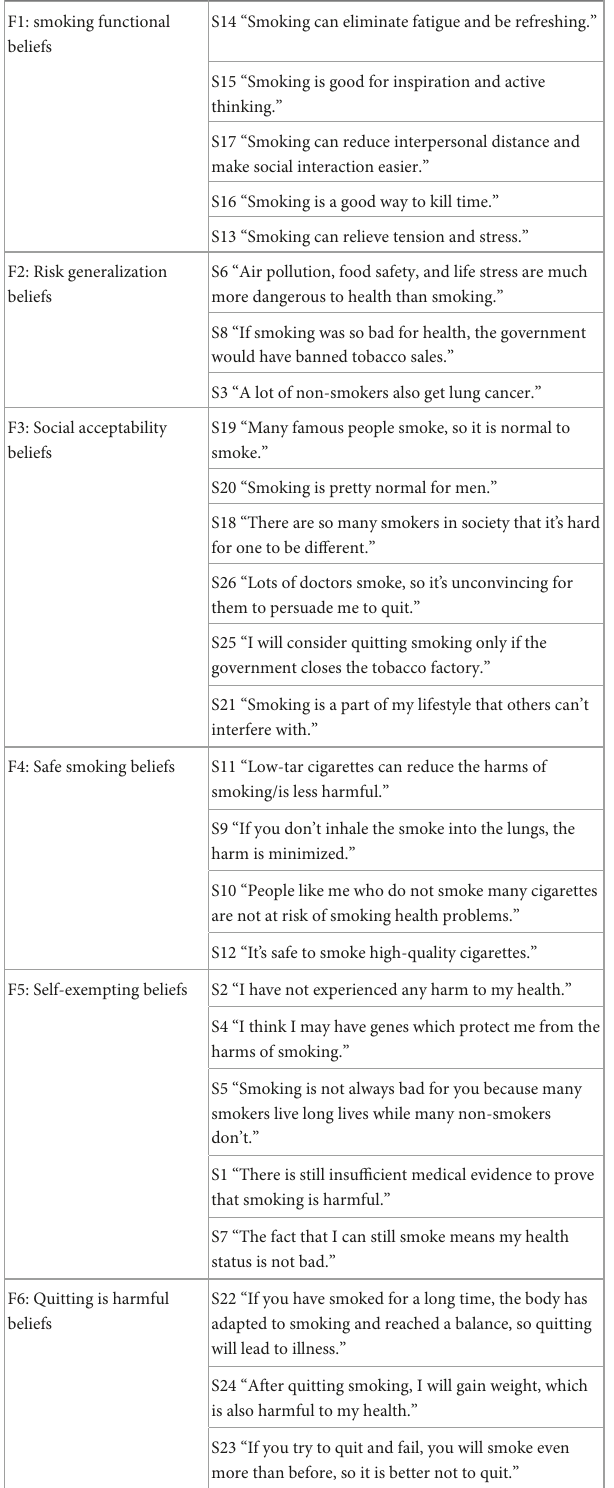
TABLE 1 The original version of the smoking rationalization belief scale.